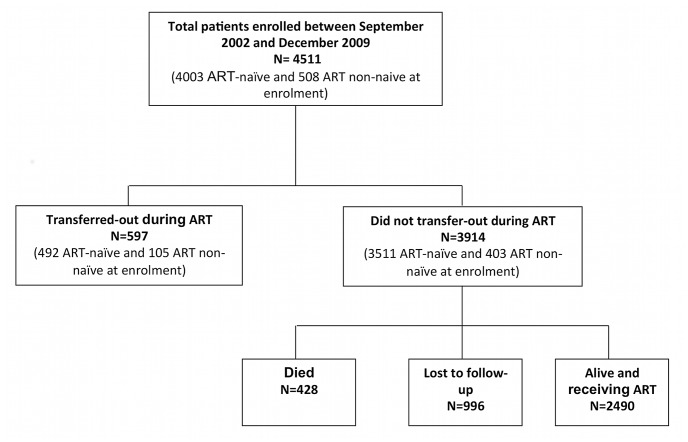
Description of patients starting ART at a community-based ART service in Gugulethu, Cape Town between September 2002 and December 2009.